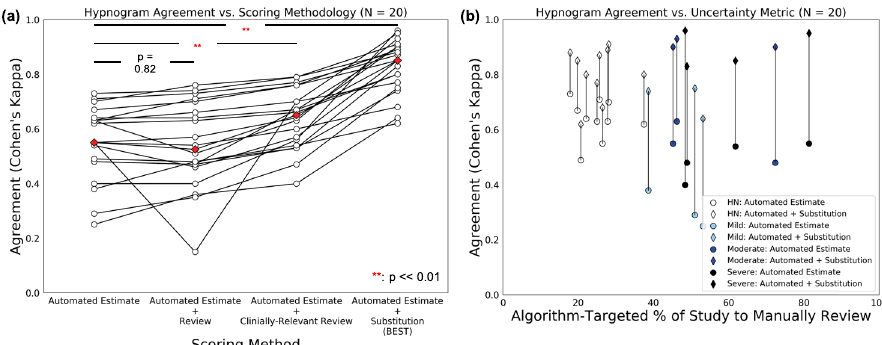
Fig. 1 Scoring agreement between ground truth and algorithm. a Idealized results for improvement in agreement between ground truth and algorithm estimate + targeted manual review, assuming perfect manual review. b Paired agreement values across different hypnograms. Red diamonds = median agreement within each group. Signi fi cance determined via paired samples t